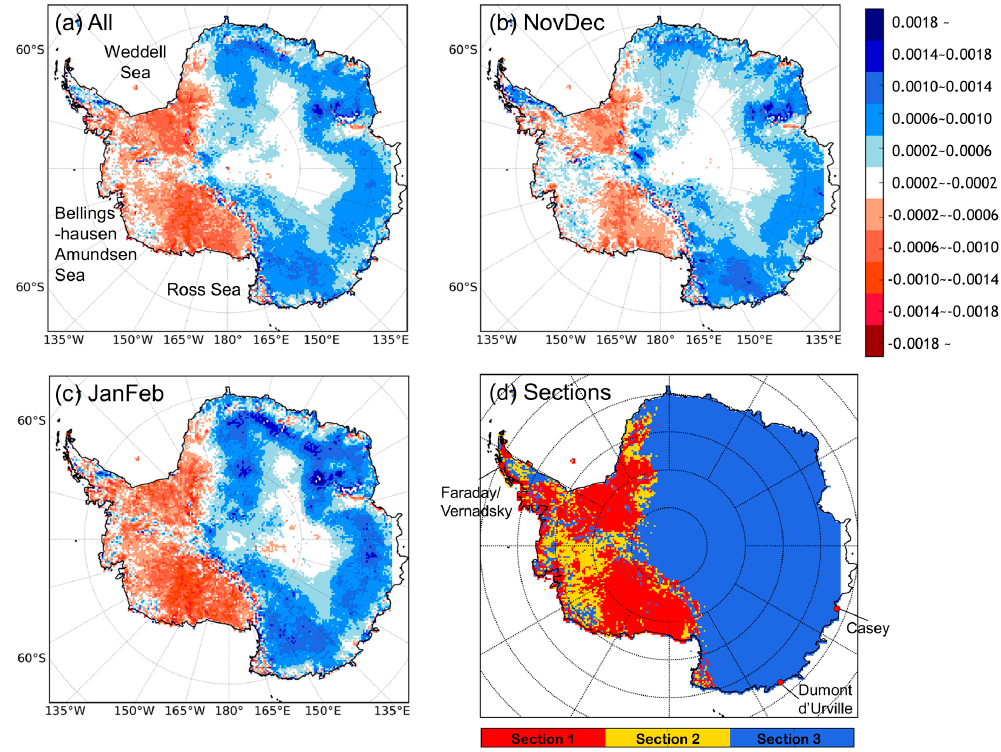
Figure 1. Spatial distribution of the change of albedo per year from 1983 to 2009 by pixel over Antarctica, and albedo variability values are divided into 11 levels with intervals of 0.0004. Blue shading indicates a positive trend of albedo mean in each of the periods and red shading indicates a negative trend. ( a ) Albedo mean for the whole period; ( b ) albedo mean for November–December; and ( c ) albedo mean for January–February; ( d ) Classification of Antarctica from change of albedo per year. Red color is Section 1, in which the rate of change of albedo decreased for all of the study period; yellow is Section 2, where the rate of change decreased in January–February but increased in November–December; and blue is Section 3, where the rate of change of albedo increased for the entire study period. Red dots indicate locations of stations.